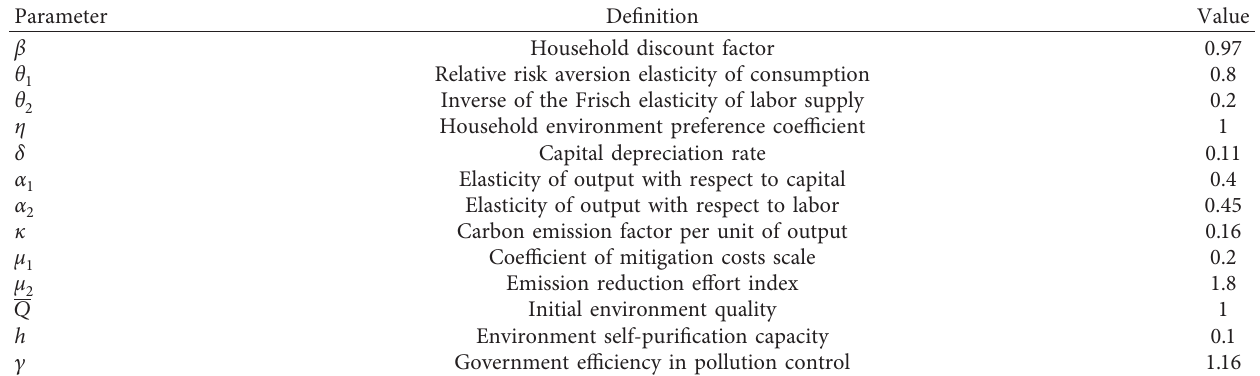
Table 1: Calibration results of static parameters.